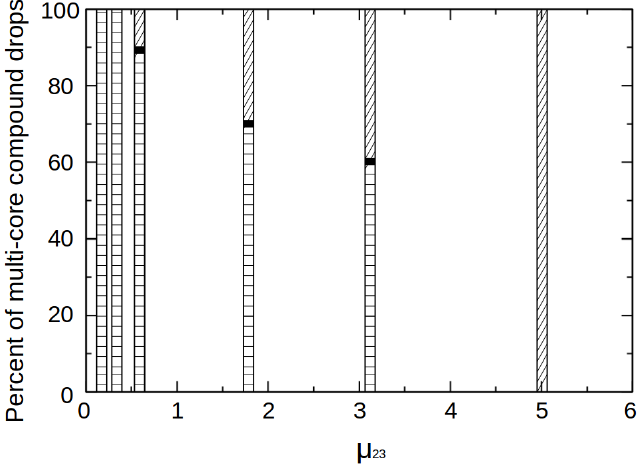
Figure 12. Percent of multi-core compound drops formed vs. intermediate-to-outer viscosity ratio. The horizontal and slant lines depicted in this plot correspond to 1-core and 2-core compound drops formation